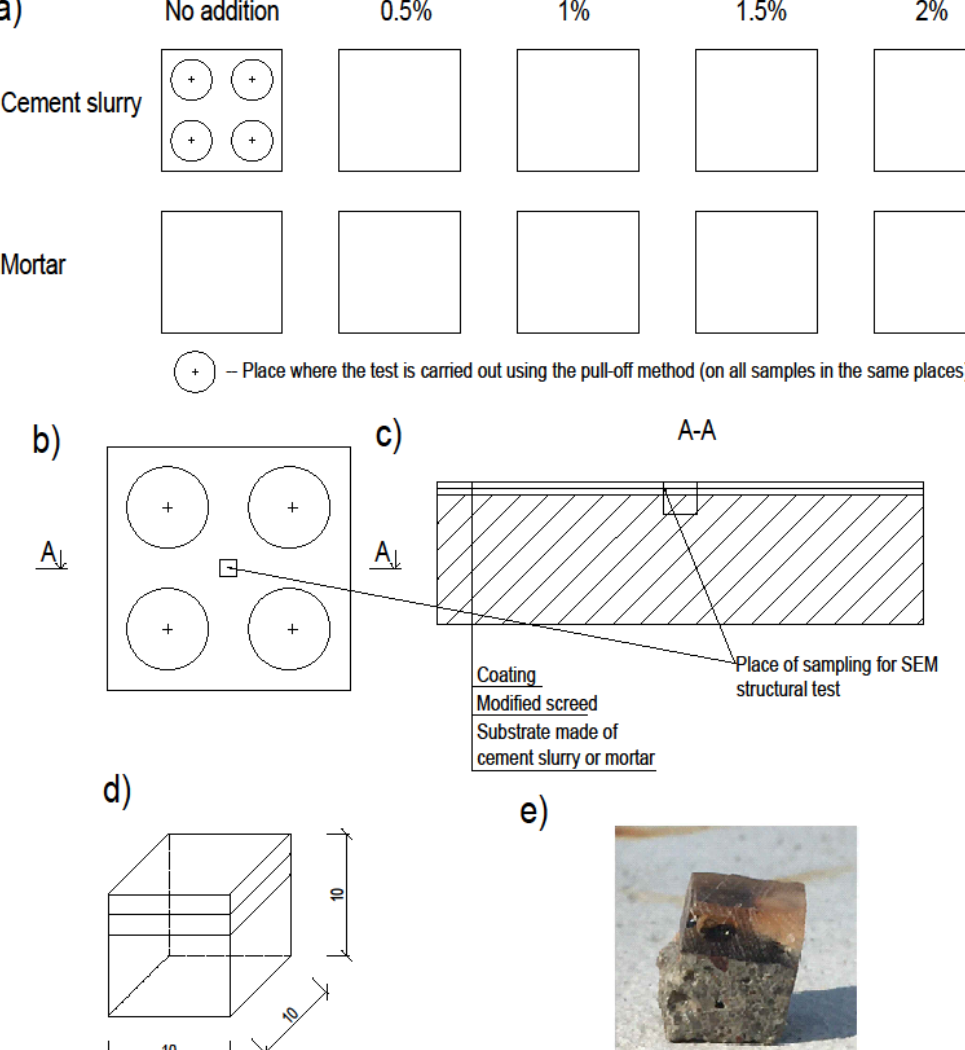
Figure 5. Samples prepared for testing: ( a ) division of samples into test fields, ( b ) a single sample with the place of sample collection for the SEM structural test, ( c ) cross-section through the sample, ( d ) a cut cube with dimensions of 10 × 10 × 10 mm subjected to the SEM structural test, ( e ) photo of the cut sample for SEM testing.